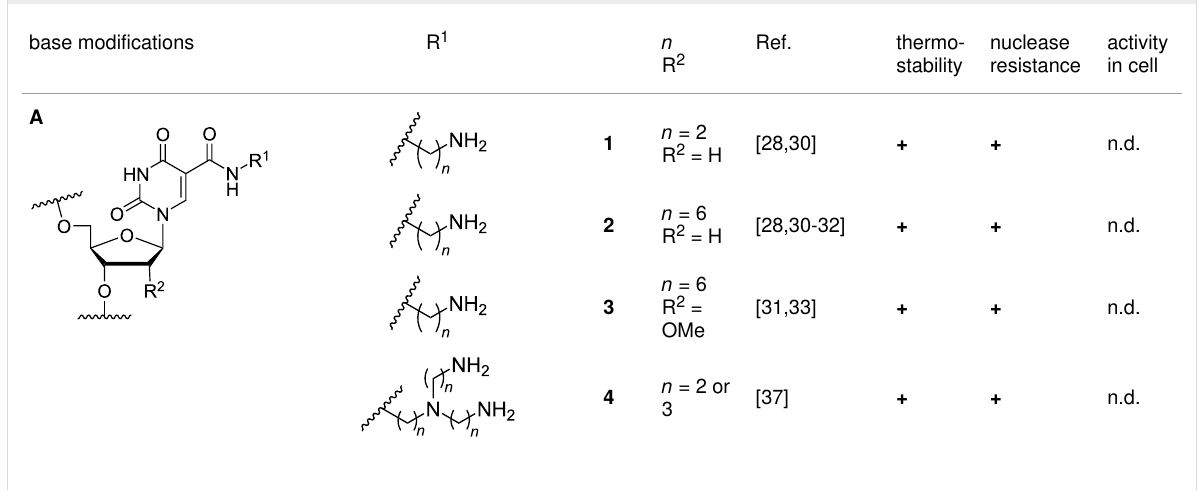
Table 1: Amine-functionalized groups on the nucleobase. a